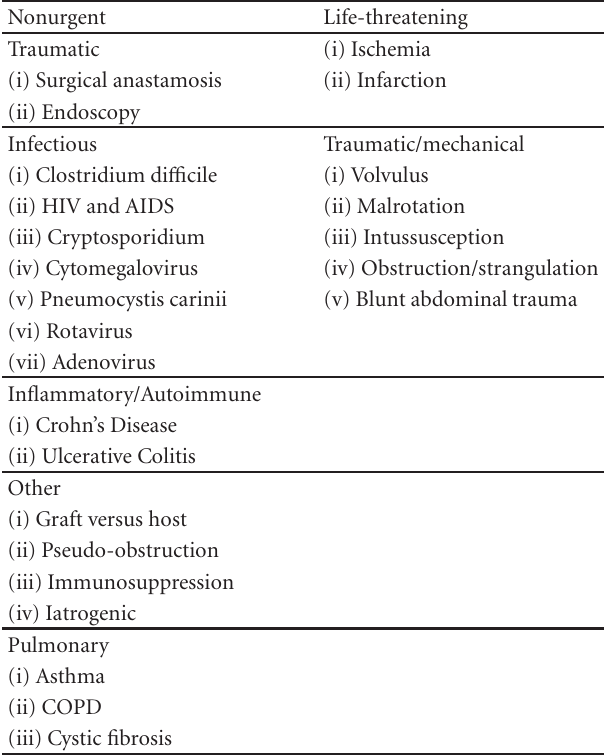
Table 2: Prominent causes of pneumatosis intestinalis. Nonurgent